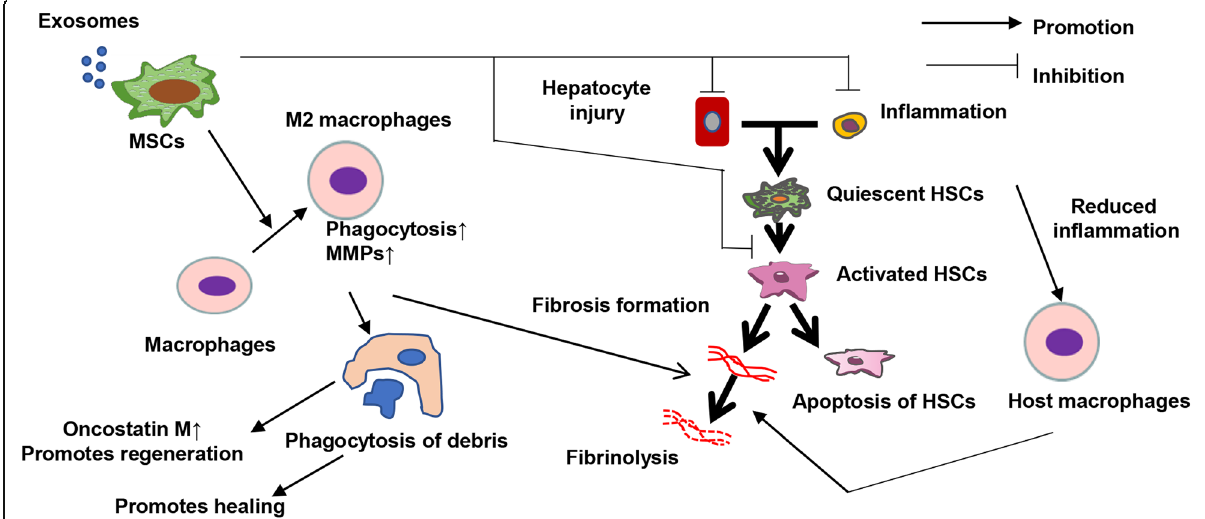
Fig. 1 Mechanisms of MSCs for liver disease. MSCs have various effects including the reduction of hepatocyte injury and inflammation. Additionally, MSCs affect macrophages and increase matrix metalloproteinase expression and phagocytosis, promoting the regenerative